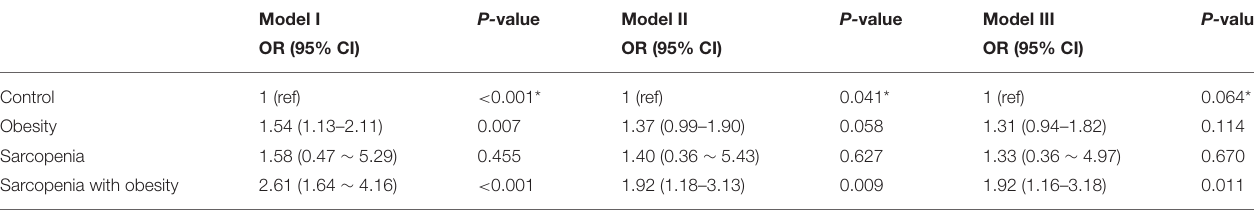
TABLE 3 | Multivariate analyses of the risk for coronary artery calcification according to sarcopenia with or without obesity.